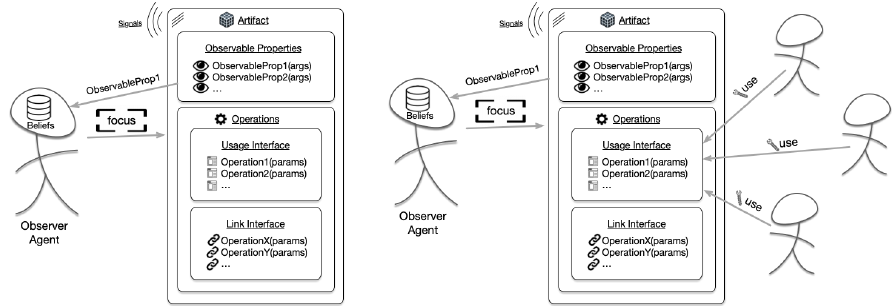
Figure 4. Artifact–agent interaction model: observation (left—focus; right—percepts and events). As defined in